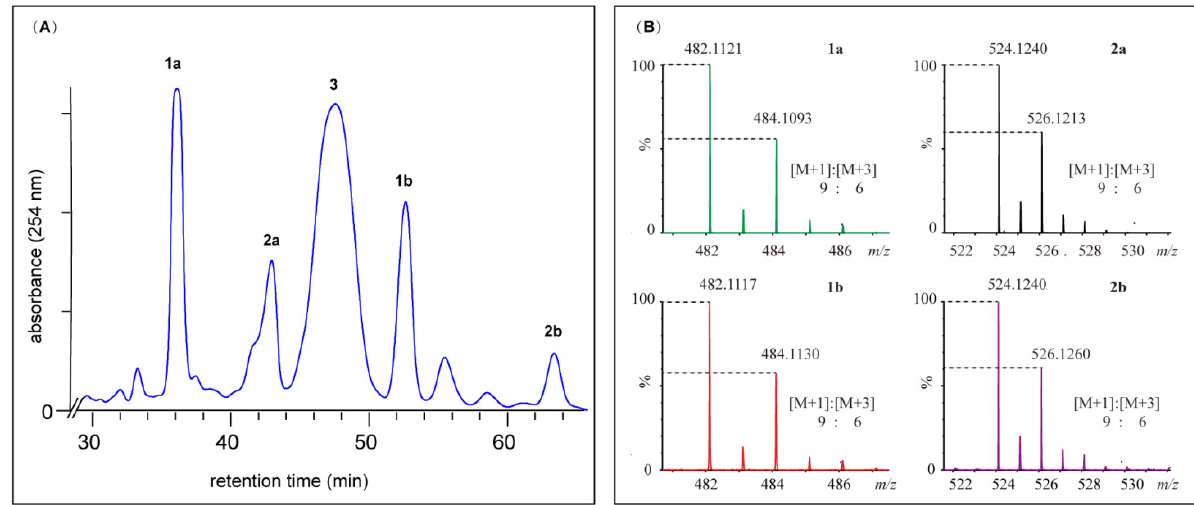
Figure 3. HPLC-UV chromatogram of the crude extract of Pestalotiopsis rhododendri LF-19-12 cultured in M2 medium ( A ) and the isotope patterns of peaks 1a , 1b , 2a , and 2b ( B ), indicating that two chloride atoms were contained.